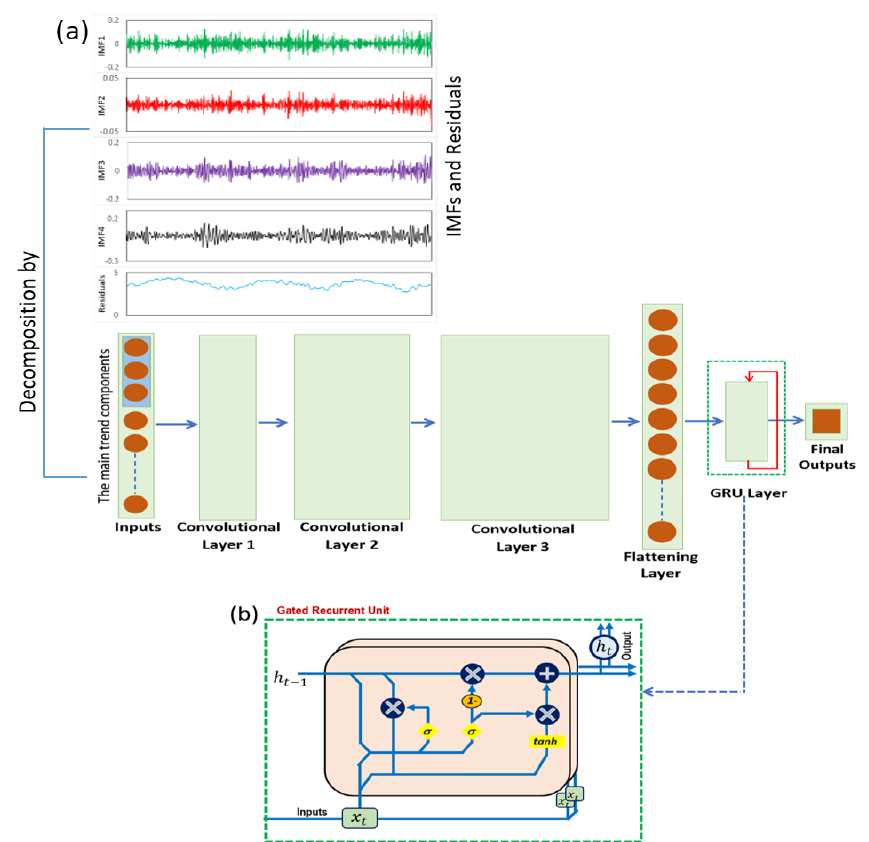
Figure 1. ( a ) Schematic of the hybrid CEEMDAN-CNN-GRU model with Complete Ensemble Empirical Model Decomposition (CEEMDAN), Convolutional Neural Networks (CNN), and Gated Recurrent Unit (GRU) Neural Network arrangement. The IMFs (Intrinsic Mode Functions) and residual series are generated in the CEEMDAN process, whereas the CNN algorithm represents the feature extraction stage. ( b ) 2-layered GRU model.